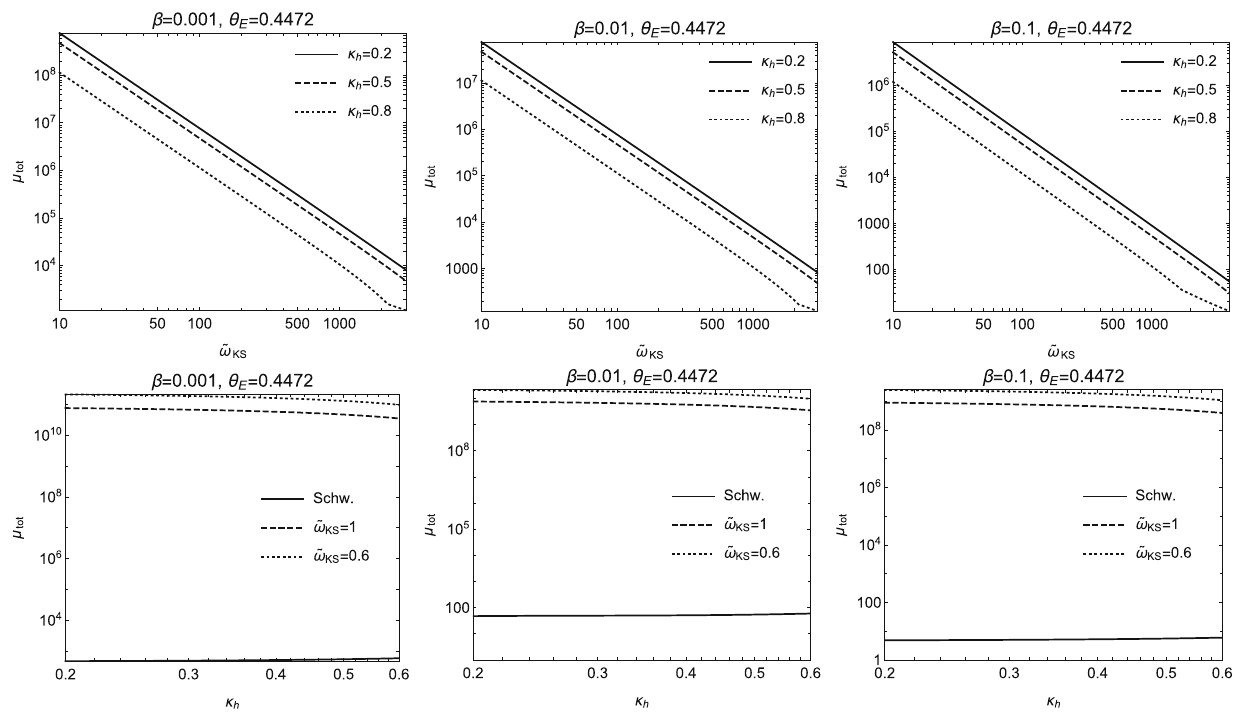
nification ( μ tot ) for homogeneous distribution of plasma with plasma parameter for different combinations of angle of source from observer- lens axis ( β ) and dimensionless “Hoˇrava” parameter ( ˜ ω θ = 0 . 4472 E